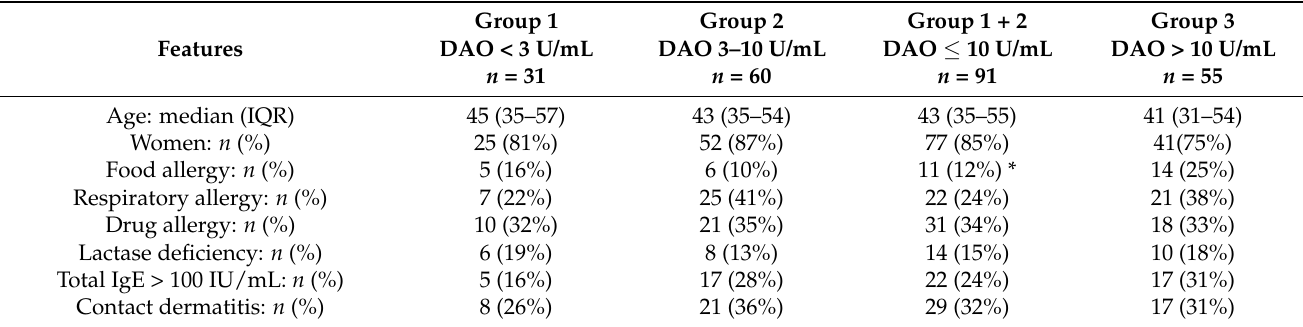
Table 1. General characteristics of the study